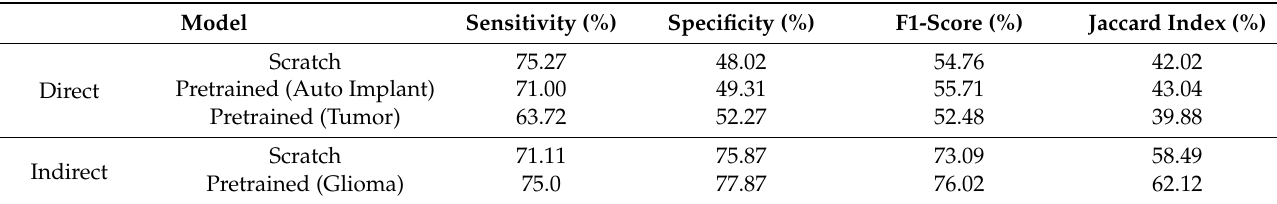
Table 1. Segmentation performance for internal validation.